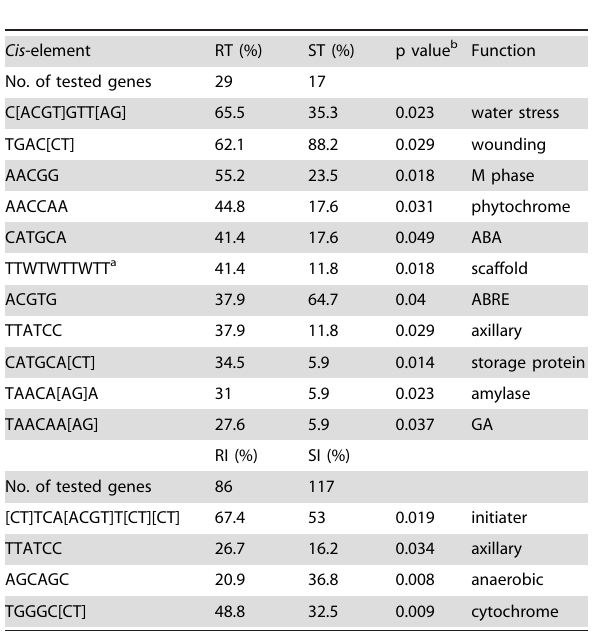
Table 2. Identification of distinct cis -regulatory elements in the tissue-enriched